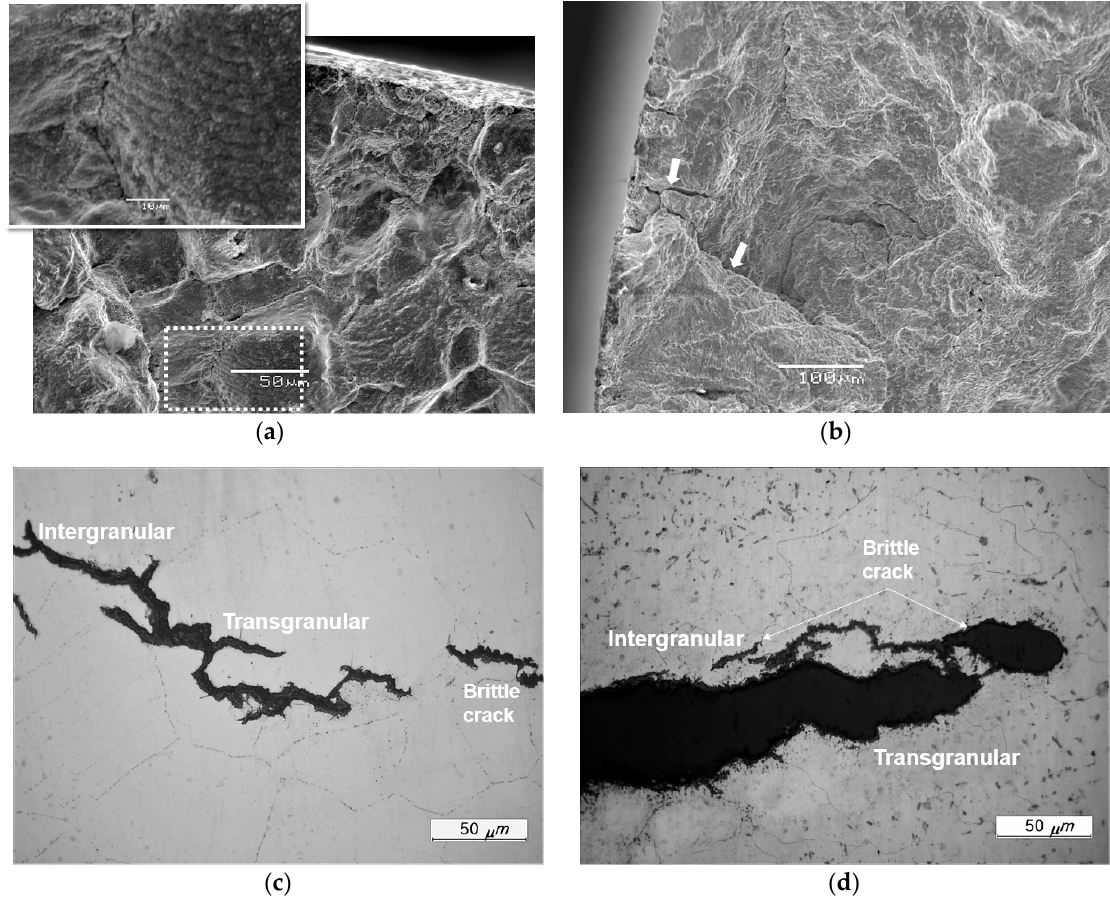
Figure 9. Typical crack morphologies of tested specimens for Alloy 617 tested at 0.6% total strain range with 60 s holding time. SEM micrographs: ( a ) Base metal; and ( b ) Weldments. Optical micrographs: ( c ) Base metal; and ( d ) Weldments.